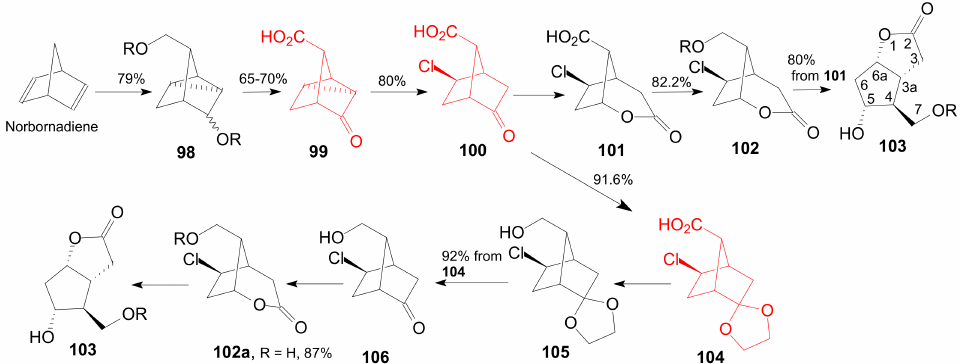
Scheme 20. Synthesis of the Corey γ -lactone 103 from norbornadiene. In red are the acid racemic compounds separated into enantiomers by dia-stereo-isomers with optically active